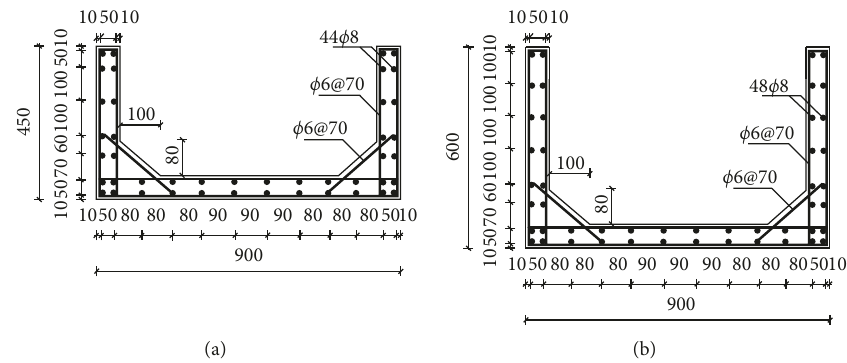
Figure 19: Girders with various characteristic lengths of (a) 1.8 m and (b) 2.5m.